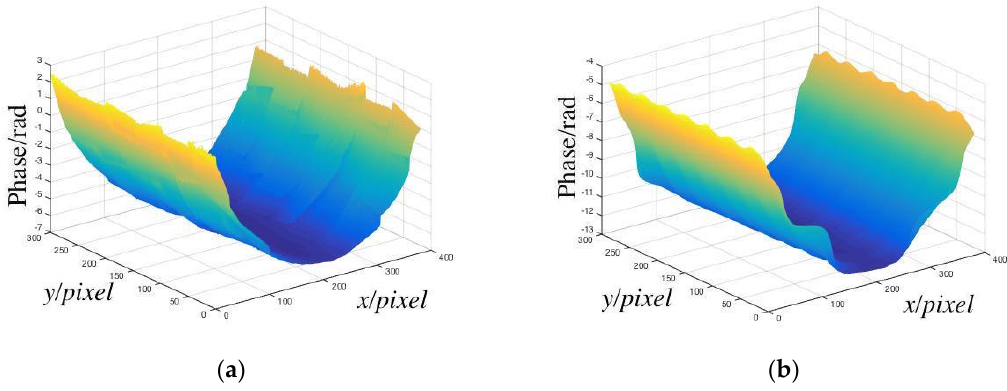
Figure 10. ( a ) Cylinder’s phase distribution calculated by machine learning; ( b ) cylinder’s phase distribution calculated by FFT.